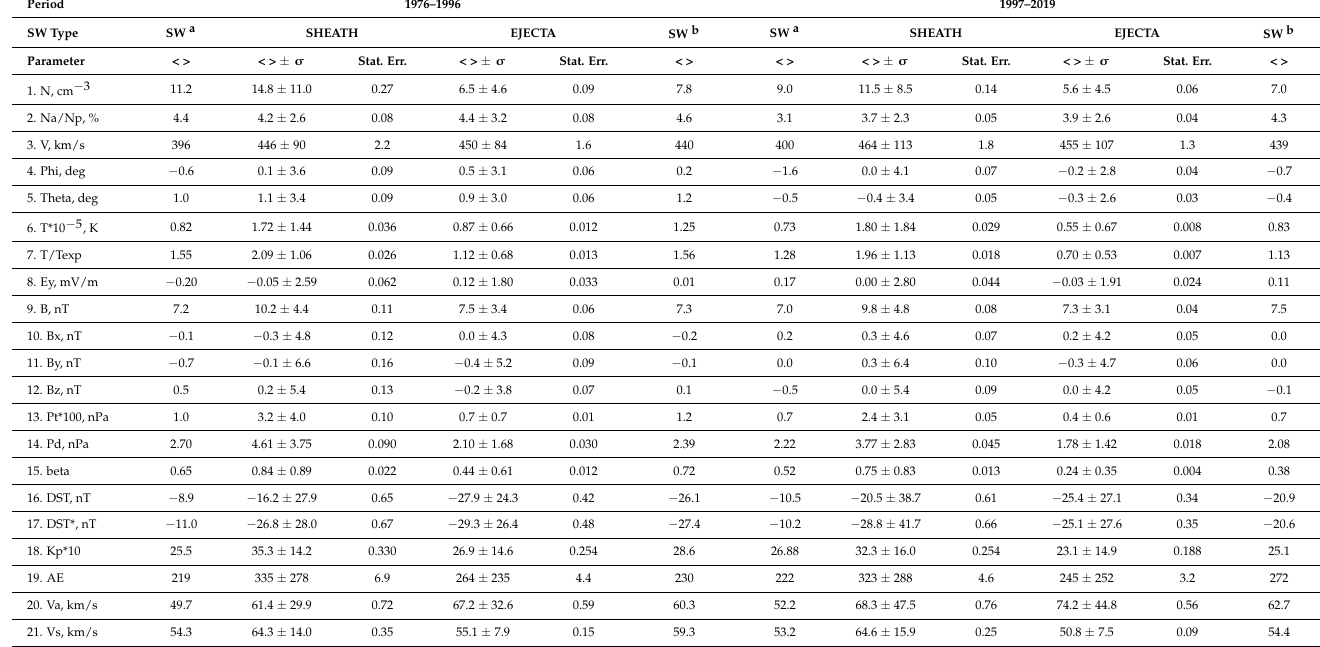
Table 5. Average parameters for sequence SW/IS/SHEATH/EJECTA/SW (Figure